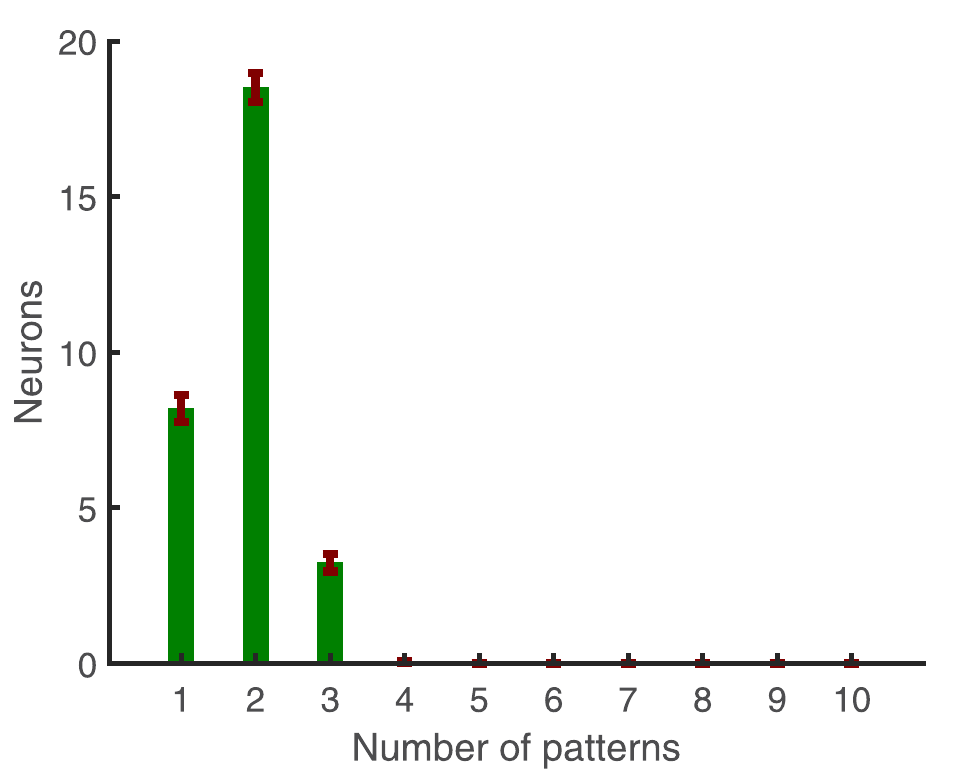
Fig 10. Contingent of neurons responding to multiple embedded patterns. Average count of post-synaptic neurons versus the number of embedded patterns detected. This figure is based on an average of 50 simulations with epoch length 1000 ms, 30 post-synaptic neurons, and 10 independent embedded patterns, having a duration of 50 ms each, ( L = 15 ms, and r 0 = 2 Hz.)